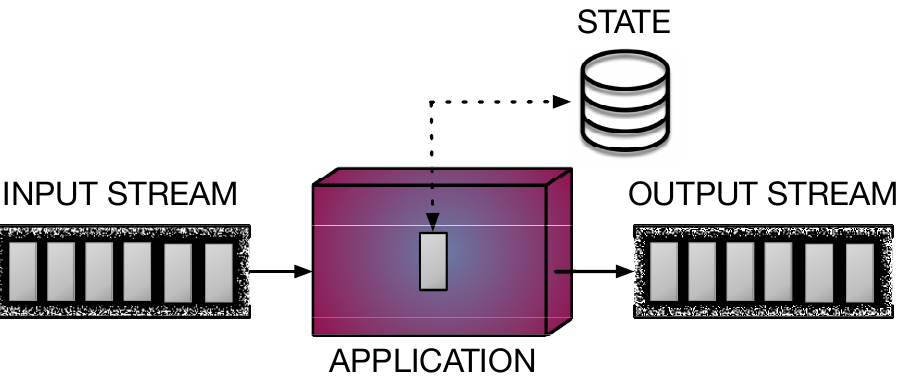
Figure 2. Stream processing application. Stream elements are represented in grey. The application receives a stream in input and performs some computation on each received item, producing a stream of results in output. Operators can be stateless or stateful , in case they maintain a state containing information on the data processed so